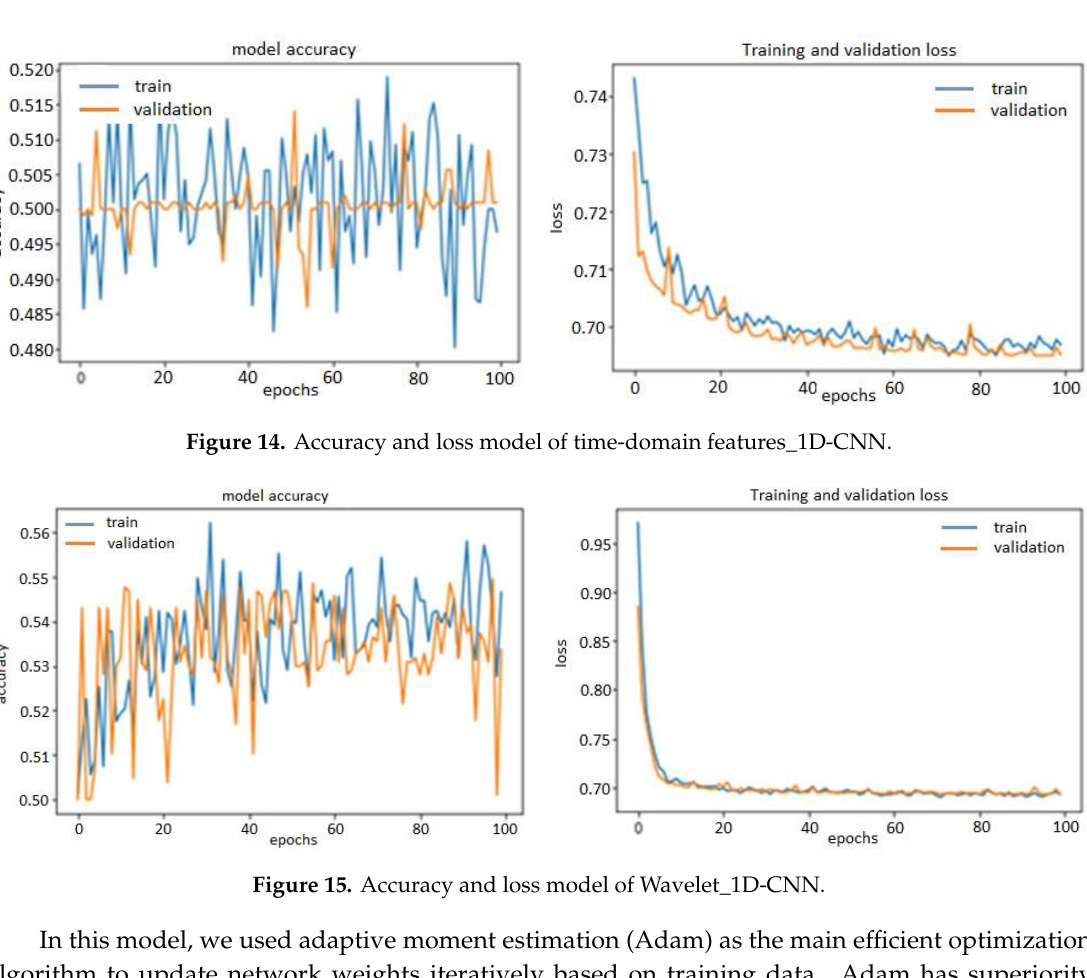
Figure 13. Accuracy and loss model of FFT_1D-CNN.